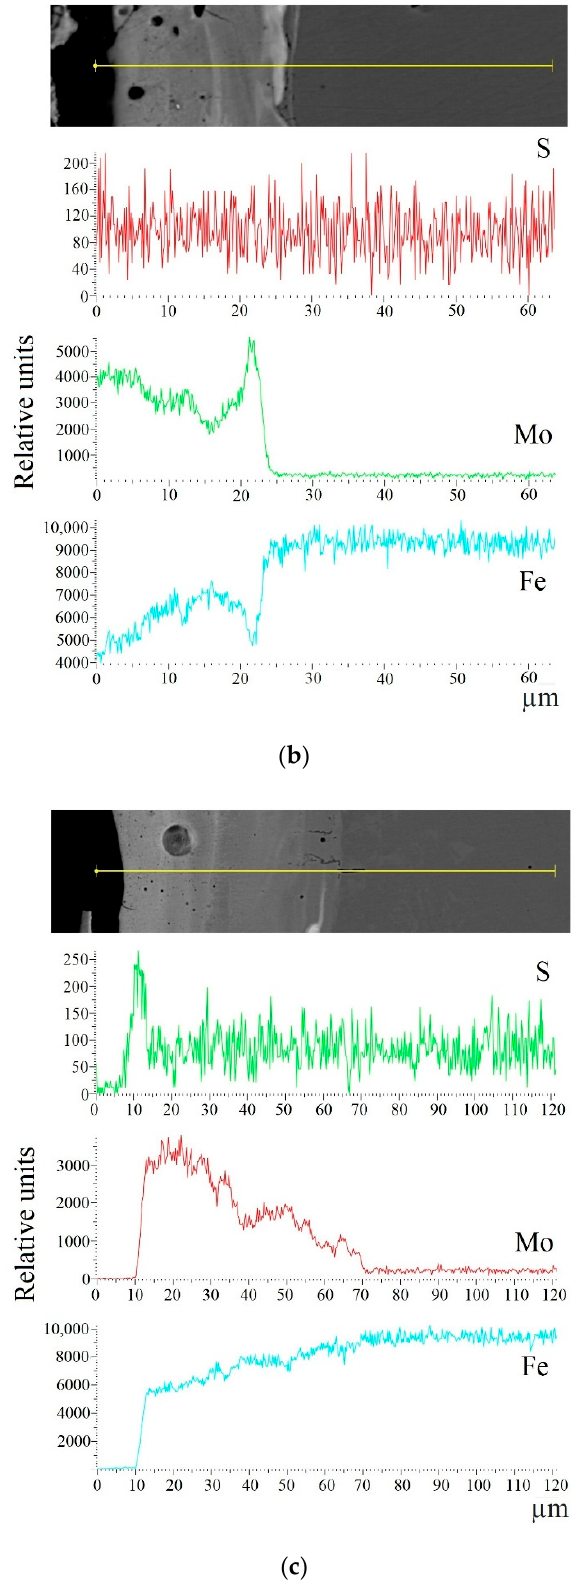
Figure 8. Distribution of elements (sulfur, molybdenum, and iron) in sulfomolybdenum coatings obtained by ESA method on steel C40: ( a ) Wp = 0.13 J; ( b ) Wp = 0.55 J; ( c ) Wp = 3.4 J.